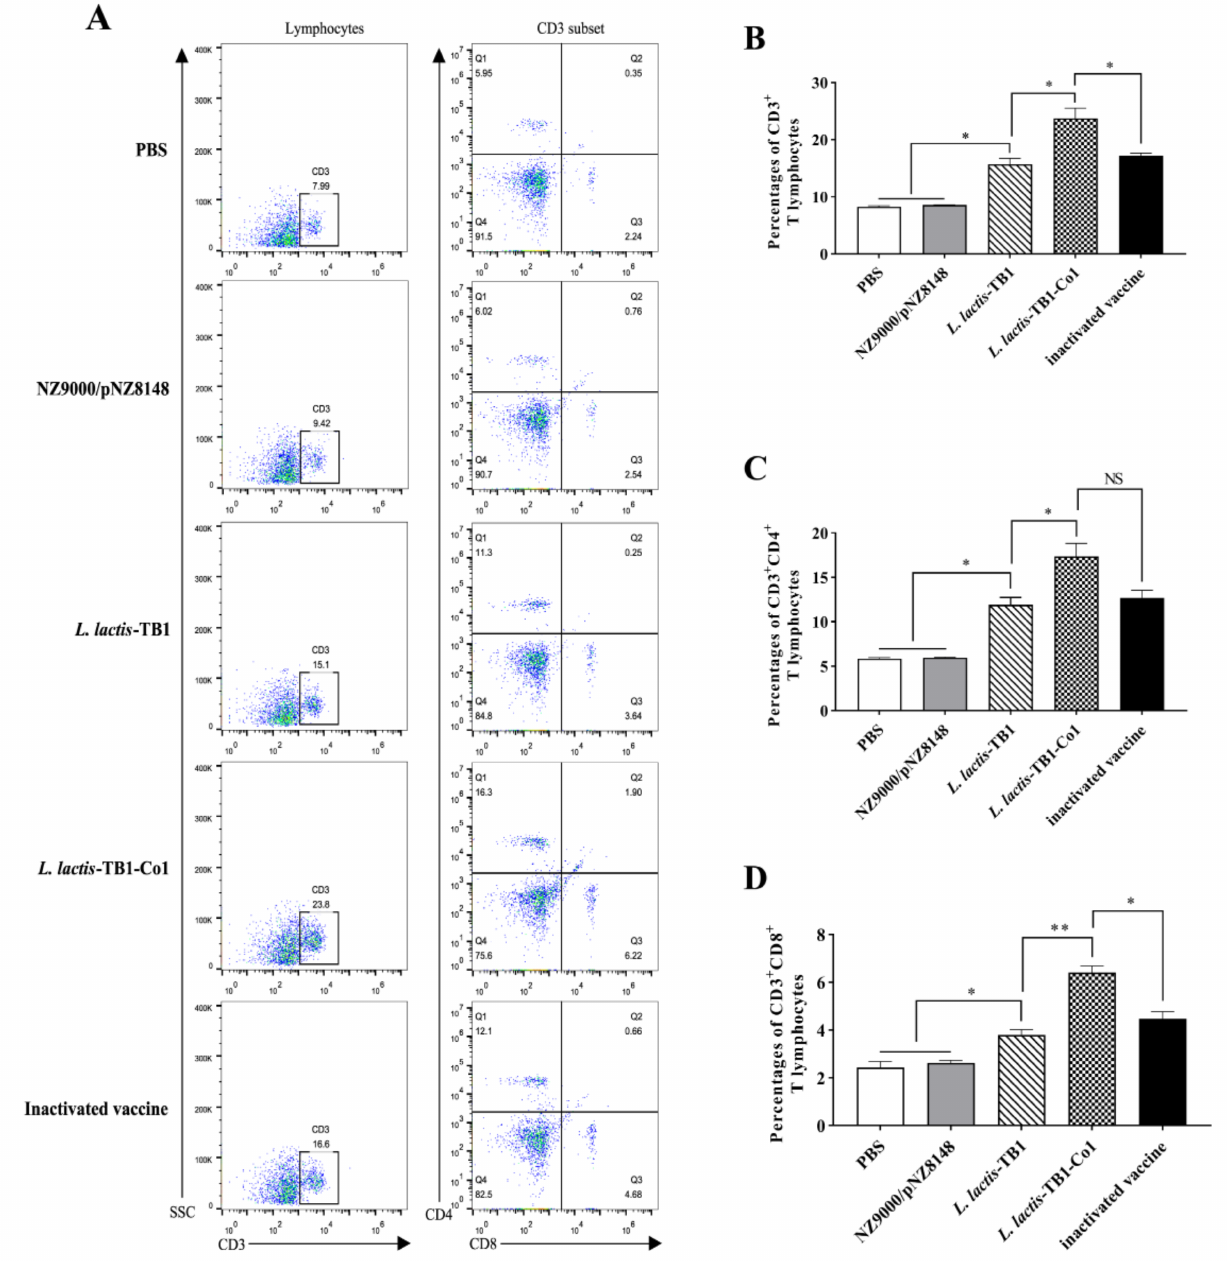
Figure 4. Percentage of CD3 + , CD3 + CD4 + , and CD3 + CD8 + T lymphocytes in mice peripheral blood at day 30. ( A ) The representative flow cytometry plots showing CD3 + , CD3 + CD4 + and CD3 + CD8 + T lymphocytes in the peripheral blood. ( B ) Frequencies of CD3 + T lymphocytes. ( C ) Frequencies of CD3 + CD4 + T lymphocytes. ( D ) Frequencies of CD3 + CD8 + T lymphocytes. Data are presented as mean ± SD. Analyses were performed by t tests (NS = p > 0.05; * p < 0.05; ** p <